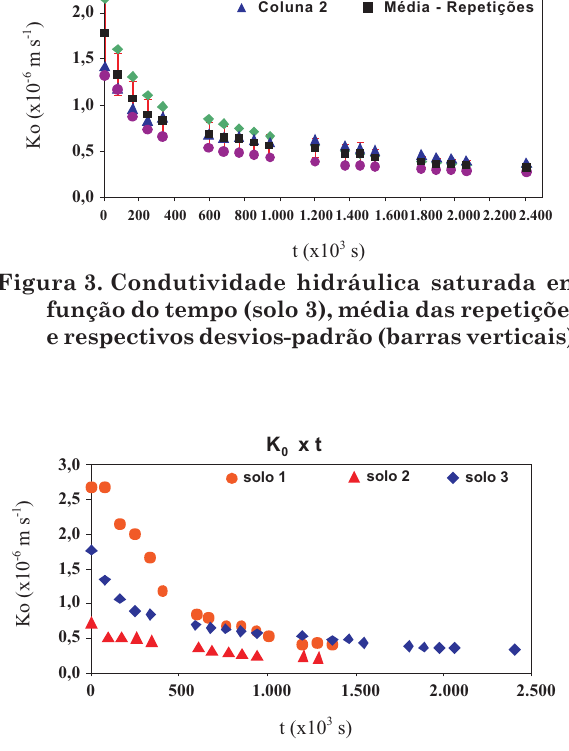
Figura 4. Média das condutividades hidráulicas saturadas, em função do tempo, para os três solos.